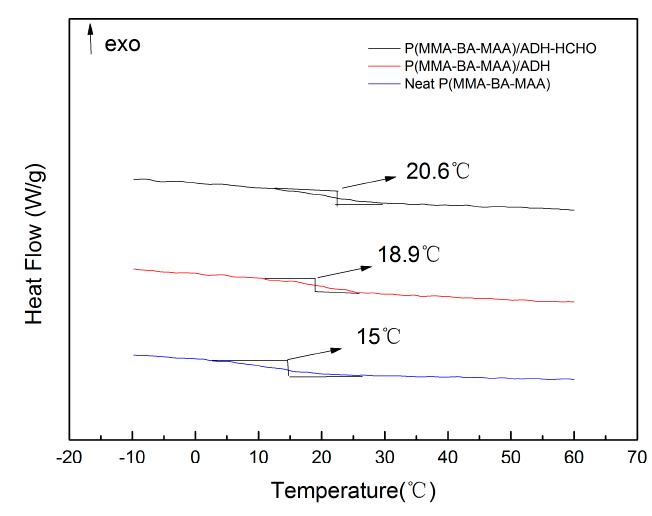
Figure 10. DSC curves of neat P(MMA-BA-MAA), P(MMA-BA-MAA)/ADH, and P(MMA-BA-MAA)/ADH-HCHO hybrid films.